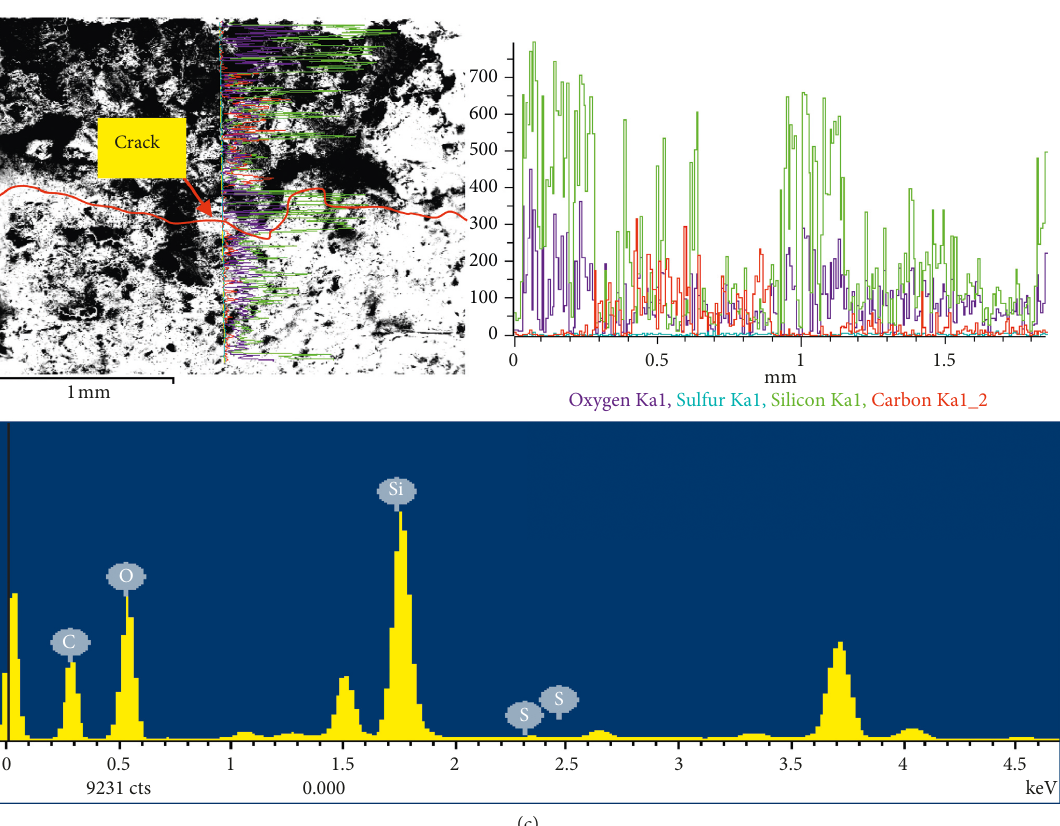
Figure 13: EDS analysis for ECC incorporating MgO and